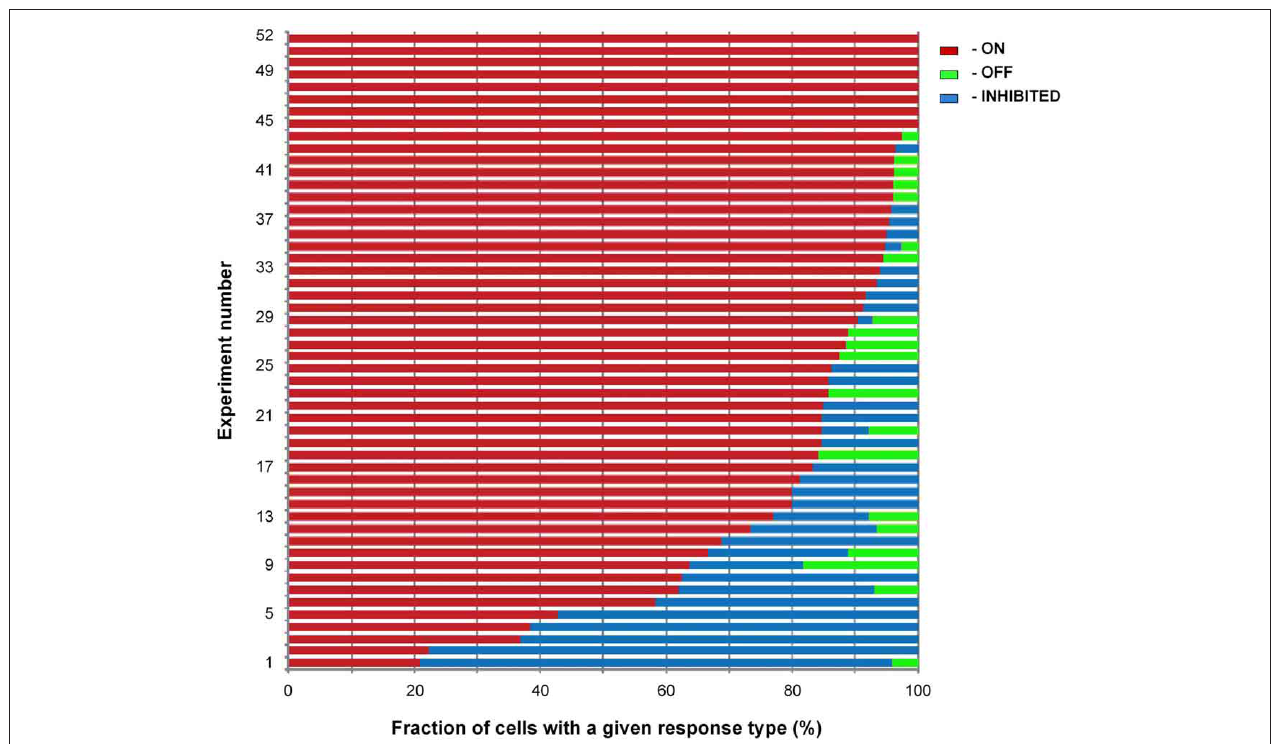
FIGURE 5 | Distributionofresponsetypes. Summarybarchartillustratingthe fractionofcellswithagivenresponsetypeinmeasurementsat52locationsin32 preparations (8–51 responding cells per location, median 19 cells). The odorant concentration was9% of saturated vapor. The fields of viewwere chosen to